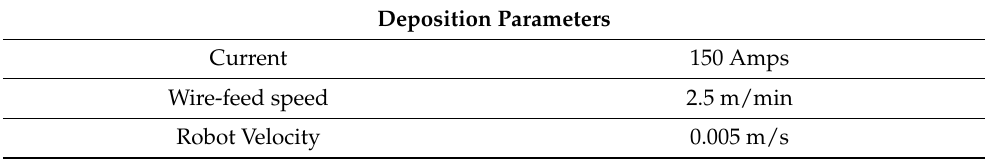
Figure 4. Deposition Path Planning for Layer 1 of an experimental WAAM wall. Table 1. Deposition Parameters. Table 1. Deposition Parameters .